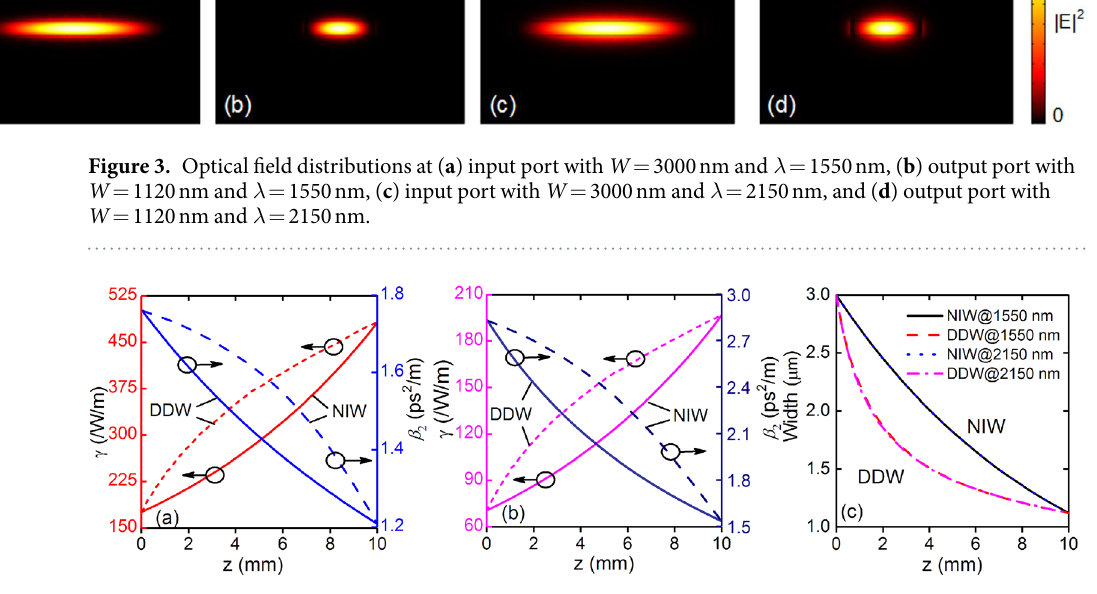
Figure 4. Variations of nonlinear coefficient γ and dispersion β 2 in NIWs and DDWs with pump wavelengths at ( a ) 1550 nm and ( b ) 2150 nm. The solid curves are the designed parameters and the dashed curves are the corresponding parameters. ( c ) The taper width profile W ( z ) of NIWs and DDWs with pump wavelengths 1550 nm and 2150